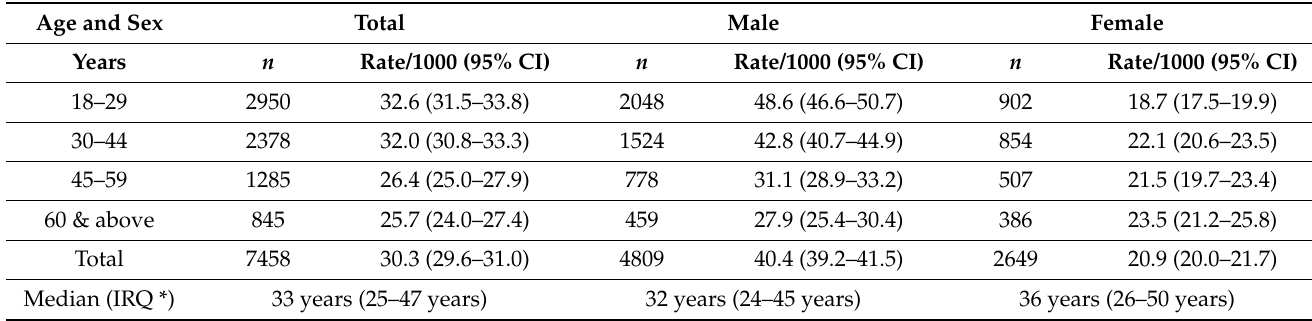
Table 1. Number and rates of ED attendance with injury by age and sex.